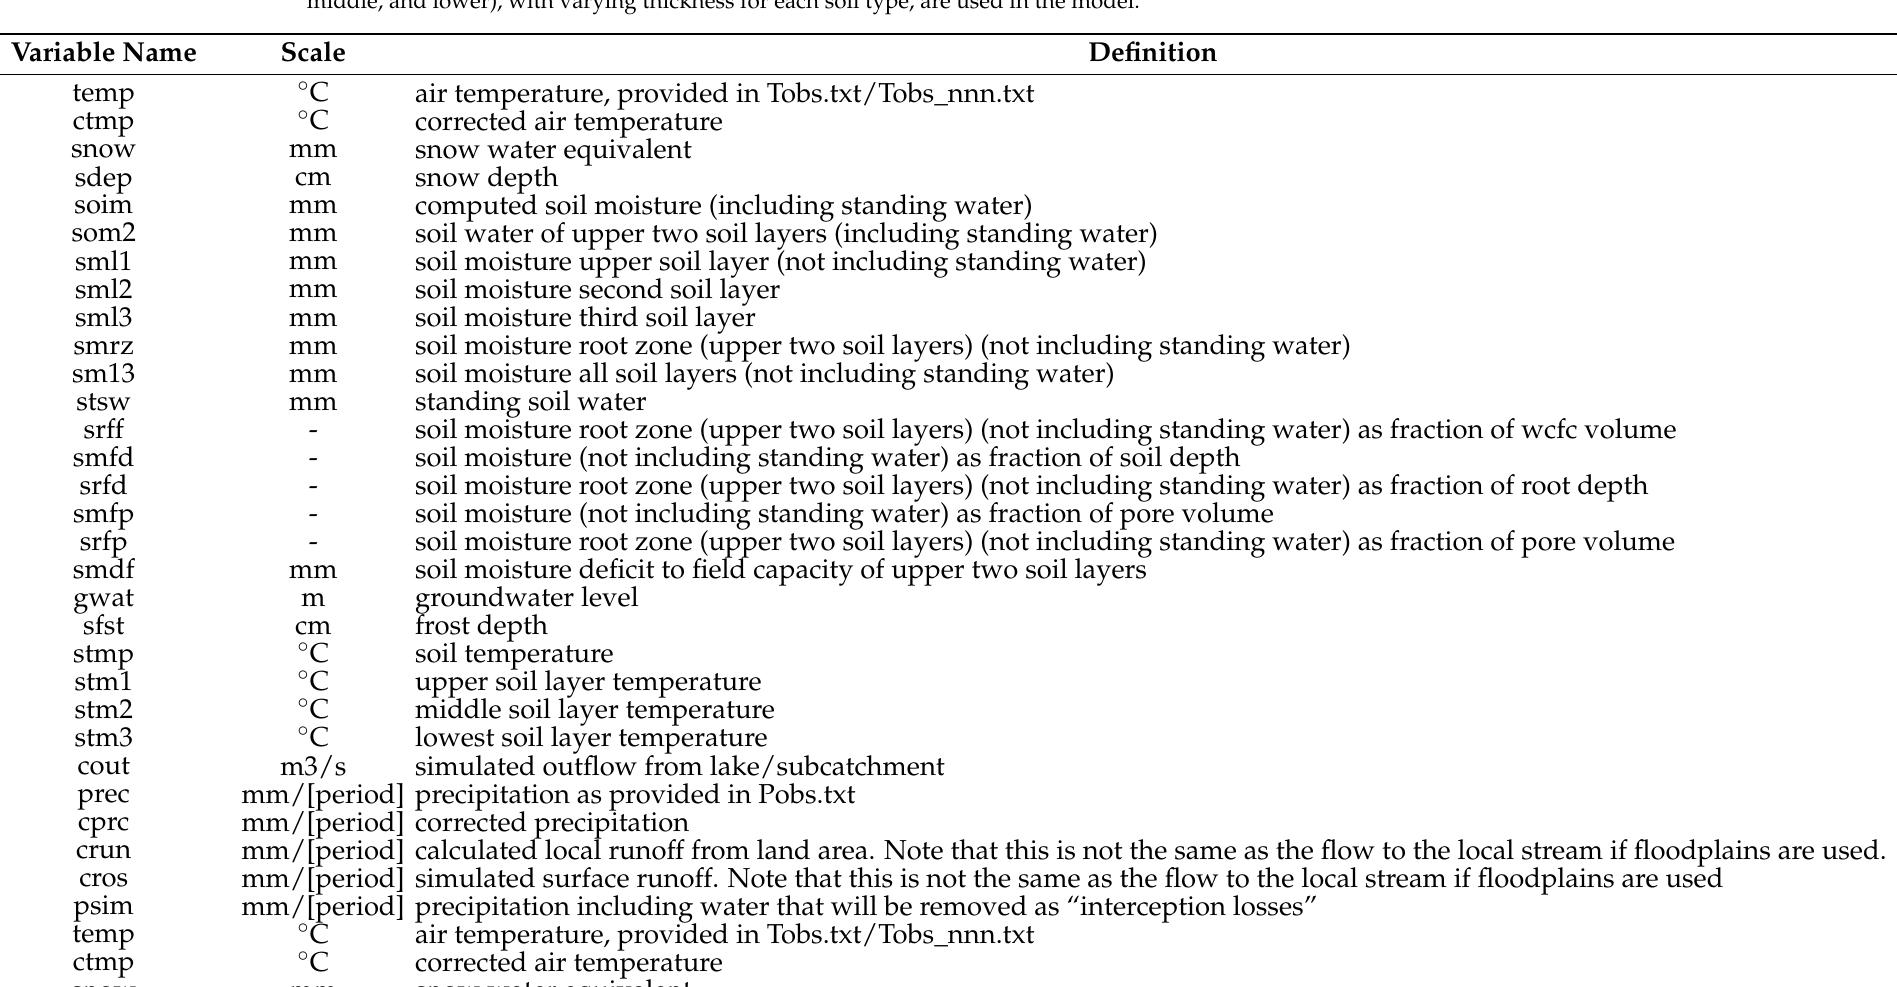
Table A2. List of S-HYPE variables used in the study to evaluate the possibility of describing the risk of rutting during logging operations. Three soil layers (upper, middle, and lower), with varying thickness for each soil type, are used in the